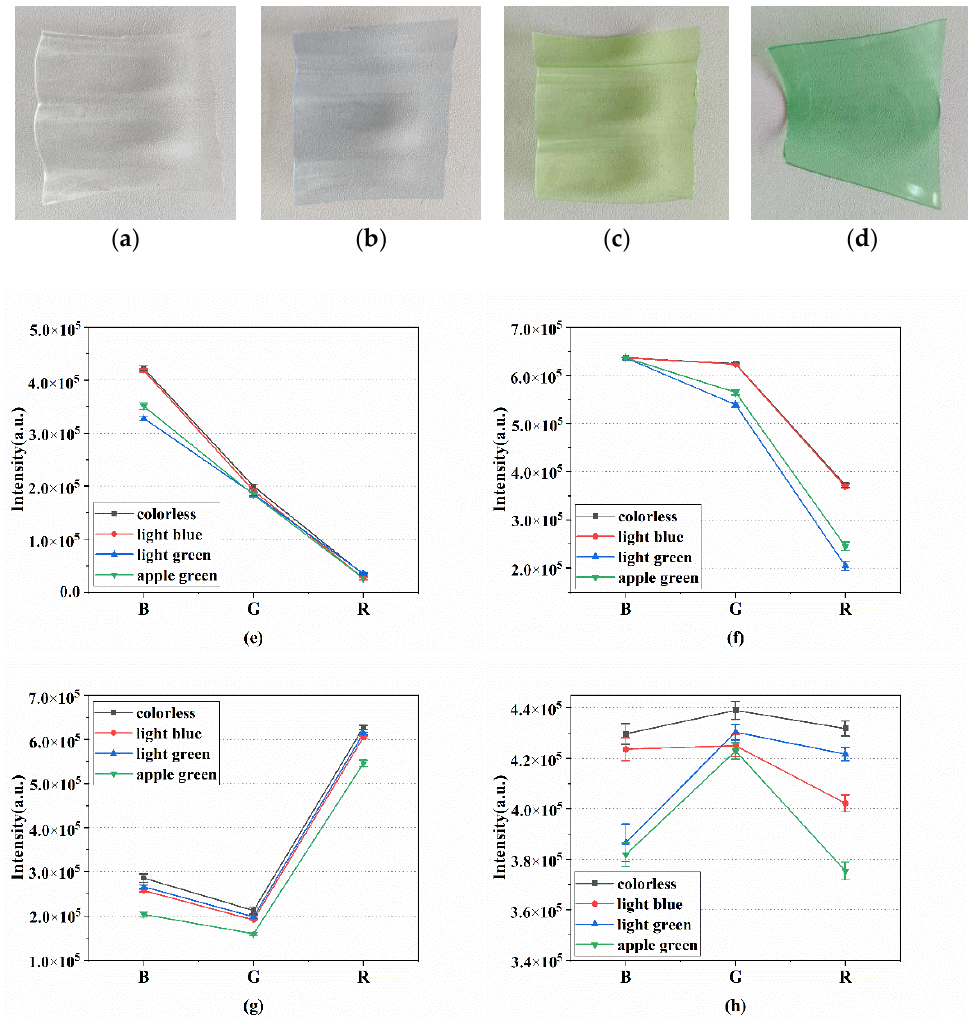
Figure 2. The colorless ( a ), light blue ( b ), light green ( c ) and apple green ( d ) transparent plastic used in the experiment and the transmission spectra of the transparent plastics at transmission light sources of 381 nm ( e ), 439 nm ( f ), 620 nm ( g ) and white ( h ). There were 40 samples for each color of plastic and each sample was, respectively, measured at 381 nm, 439 nm, 620 nm and white transmission light source to obtain the corresponding transmission spectrum. Shown in Figure 2e–h are the transmission spectra for the plastics of the 4 colors at each transmission light source. The transmission spectrum is described by R, G and B wavebands [25], and each shown spectrum is the mean of the 40 transmission spectra of the 40 samples of the same